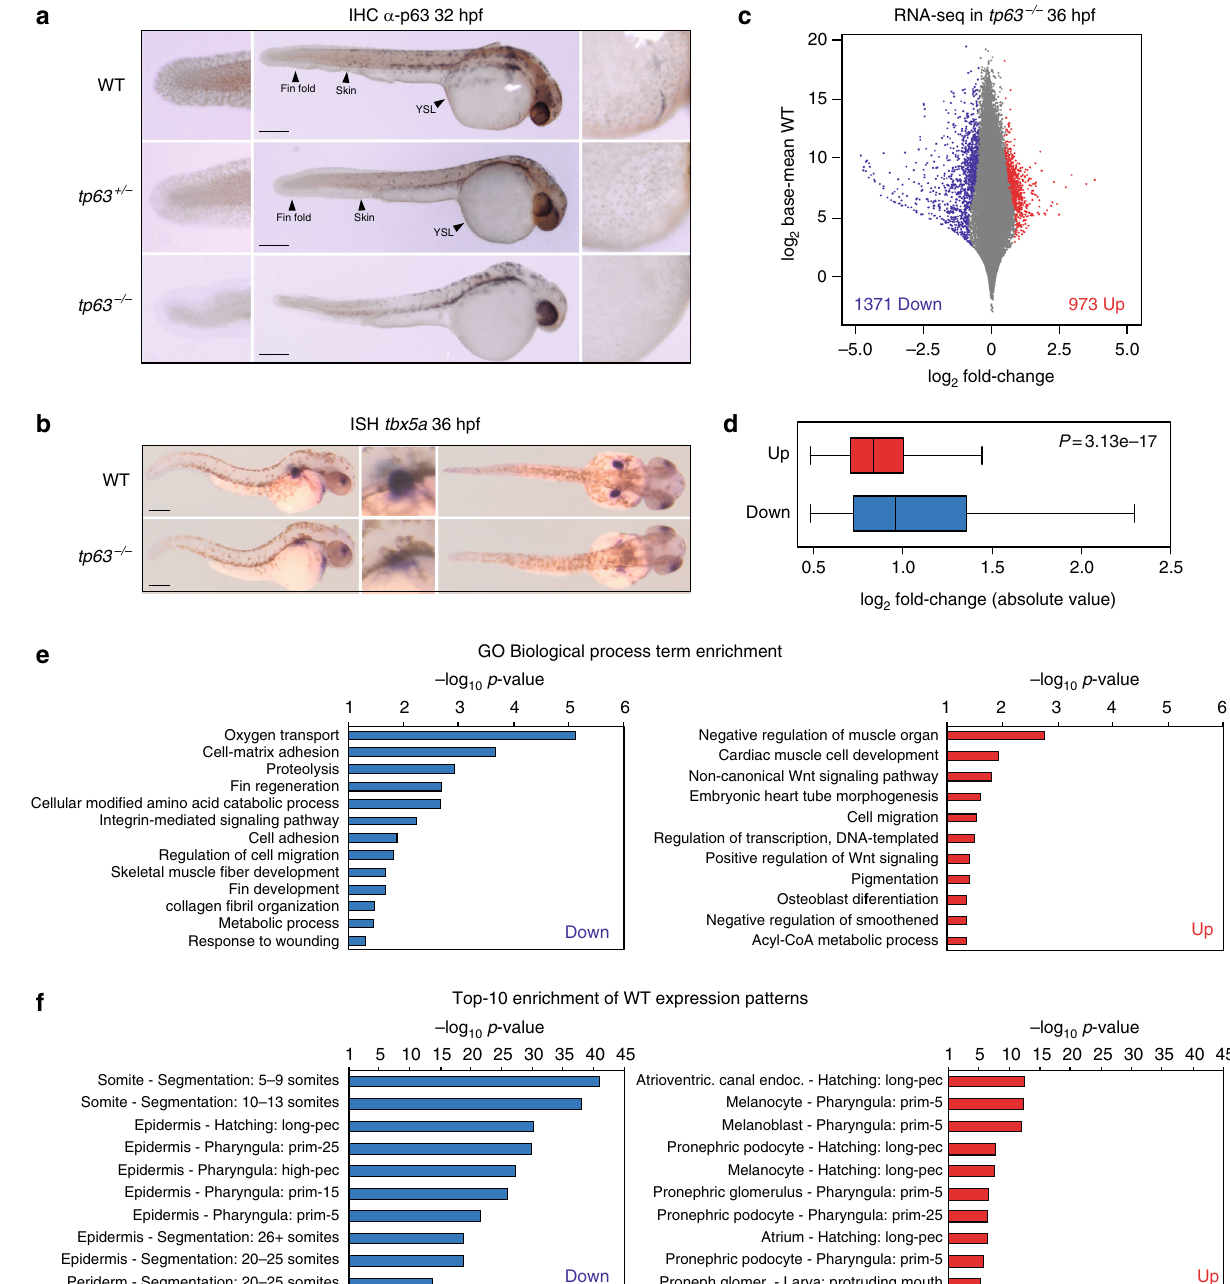
Fig. 1 Zebra fi sh tp63 − / − mutant embryos show de-regulated epidermal program. a Whole-mount embryo immunostaining of p63 in wild-type (WT), heterozygous tp63 + / − and homozygous tp63 − / − embryos at 32 h post fertilization (hpf) showing the absence of p63 expression in tp63 − / − mutants. Left, zoomed lateral view of the tail; middle, lateral view of whole-embryo; right, zoomed lateral view of the yolk. YSL, yolk syncytial layer. b Whole-mount in situ hybridization of the tbx5a gene in WT and tp63 − / − embryos at 36 hpf showing expression in eye, heart and pectoral fi n bud, the latter one being reduced in tp63 − / − mutant accordingly with the absence of this anatomical structure. Left, lateral view of whole embryo; middle, zoomed lateral view of the pectoral fi n bud; right, dorsal view of whole embryo. For a and b , anterior is to the right. For a and b , scale bars represent 250 µ m. c Differential analysis of gene expression between WT and tp63 − / − at 36 hpf from RNA-seq ( n = 3 biological replicates per condition). The log 2 base mean WT transcript expression levels versus the log 2 fold-change of expression are plotted. Transcripts showing a statistically signi fi cant differential expression ( p < 0.05) are highlighted in red (upregulated) or blue (downregulated). d Box plot representing the absolute log 2 fold-change of the up- ( n = 973) and down-regulated ( n = 1,371) transcripts from ( c ). Center line, median; box limits, upper and lower quartiles; whiskers, 1.5× interquartile range. p value according to the Wilcoxon ’ s rank sum test is shown. Source data are provided as a Source Data fi le. e Gene Ontology (GO) Biological Process term enrichment of the genes corresponding to the up- and down-regulated transcripts from ( c ). f Top-10 enrichment of WT expression patterns of the genes corresponding to the up- and down- regulated transcripts from ( c ). For e and f , the -log 10 of p -value for each term is